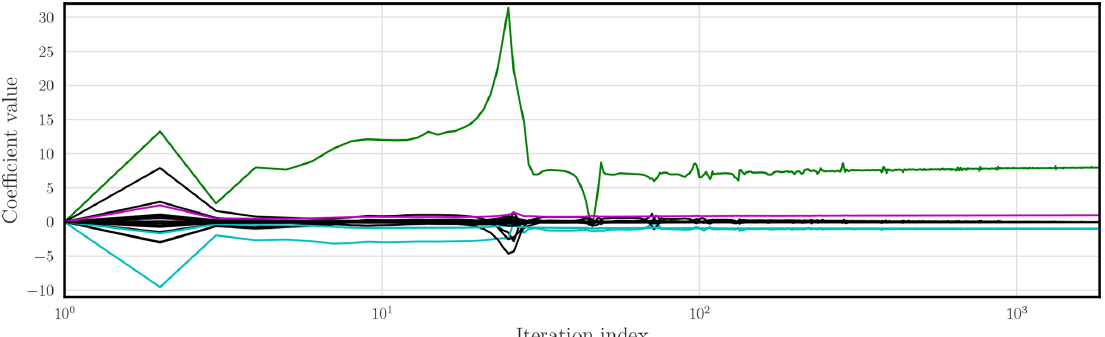
Figure 10. L96 is the reference model, which is fully observed with observation error standard deviation σ y = 1: plot of the N a = 18 coefficients of the surrogate model as a function of the minimisation iteration number. Note that the index axis is in logarithmic scale. The coefficient of the forcing ( F ) is in green, the coefficients of the convective terms are in cyan, and the dampening coefficient is in magenta.